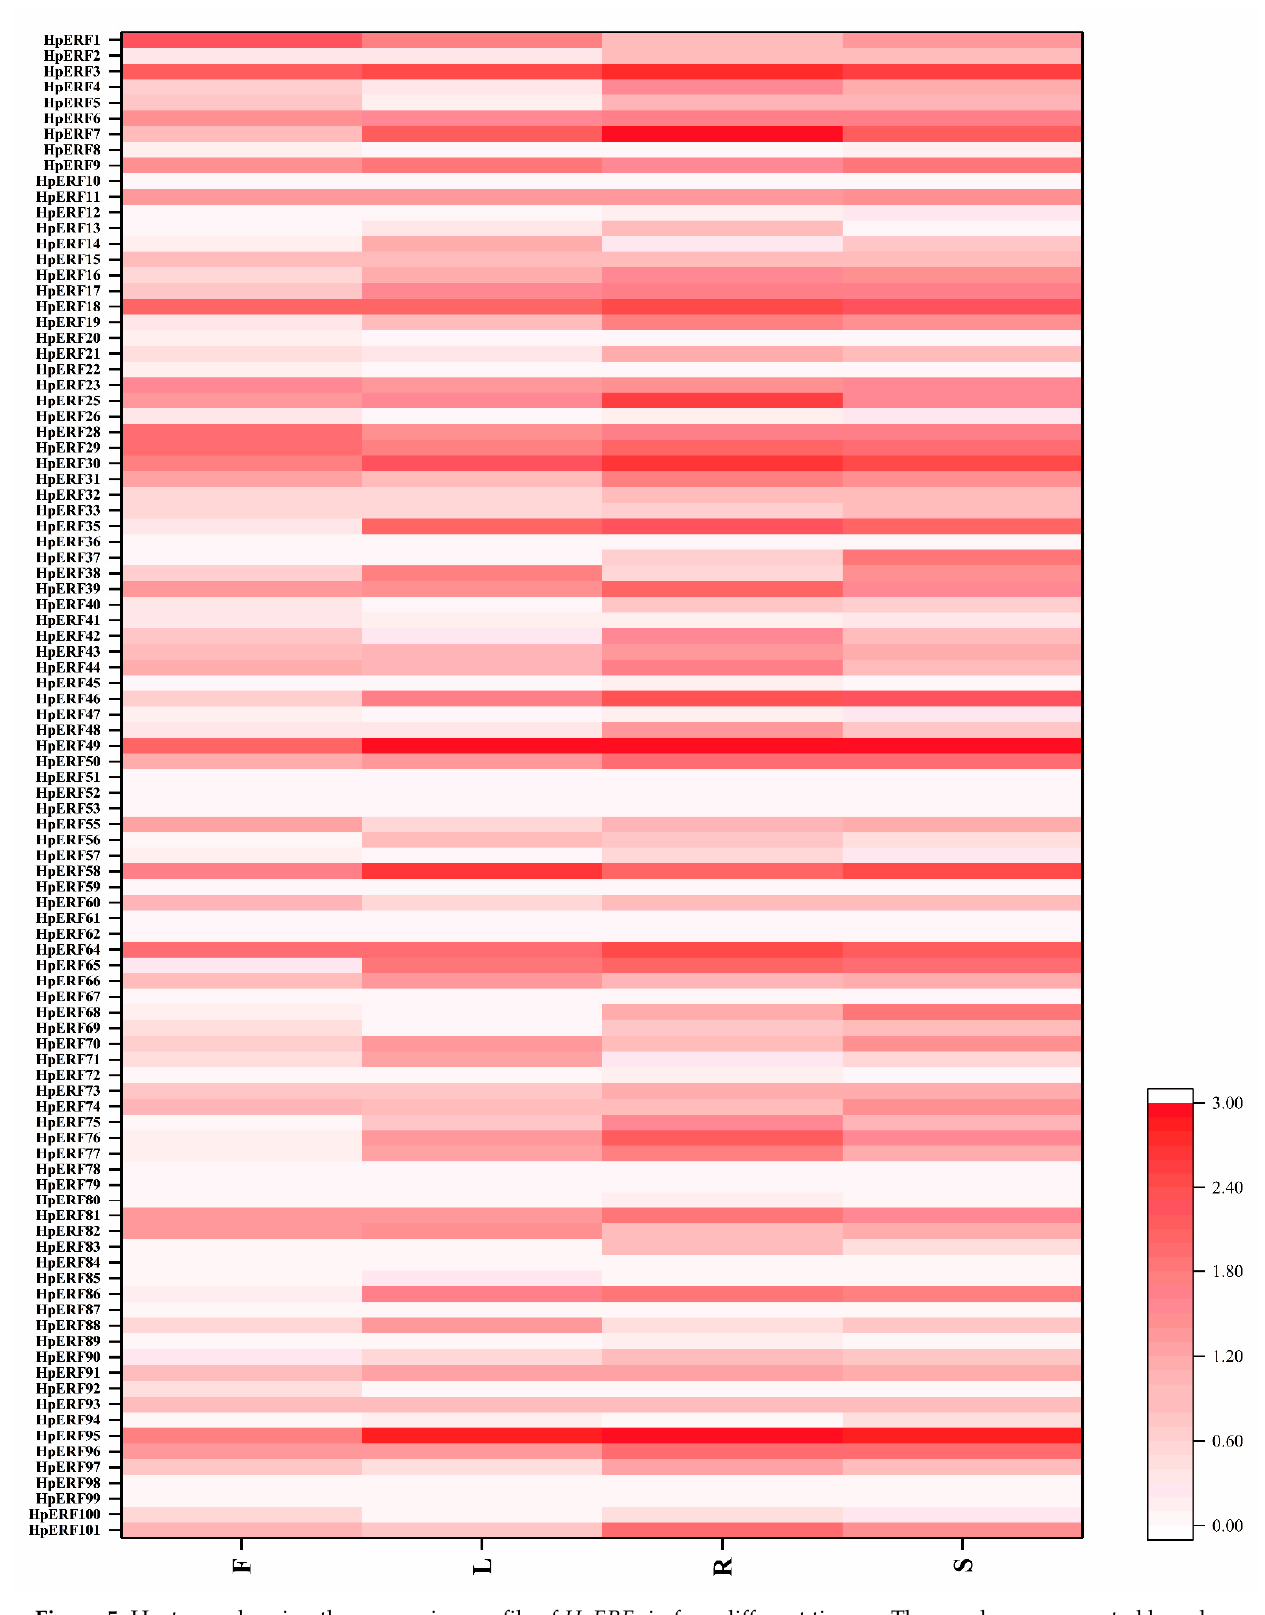
Figure 5. Heatmap showing the expression profile of HpERFs in four different tissues. The graph was generated based on log2-transformed count value from three replicates of RNA-Seq data using Origin software. Red and white boxes indicate high and low expression levels of HpERFs , respectively.